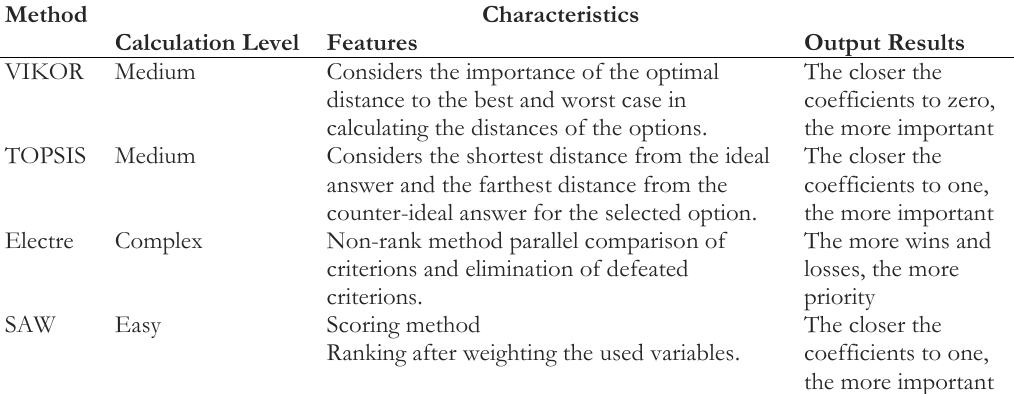
Table 21. Comparison of TOPSIS with other decision-making